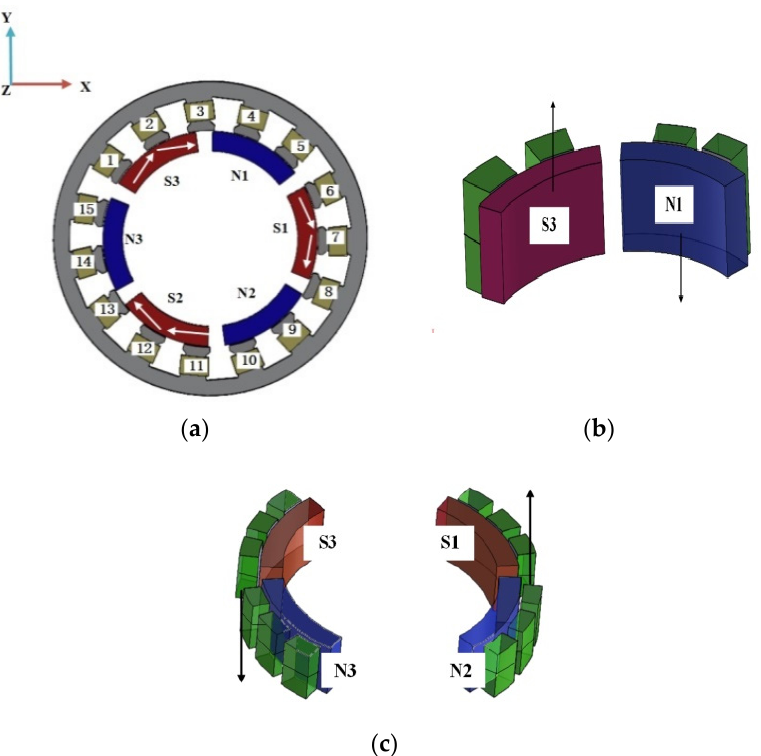
Figure 4. Electromagnetic section working principle: ( a ) z -axis positive turn; ( b ) x -axis deflection; and ( c ) y -axis deflection.